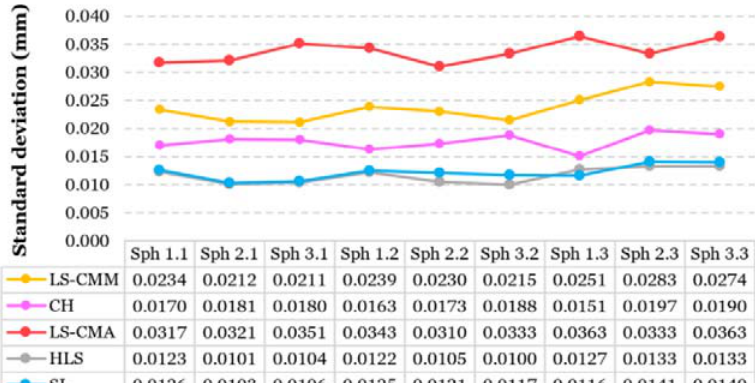
Figure 9. Standard deviation of the point clouds from the reference values (CMM).